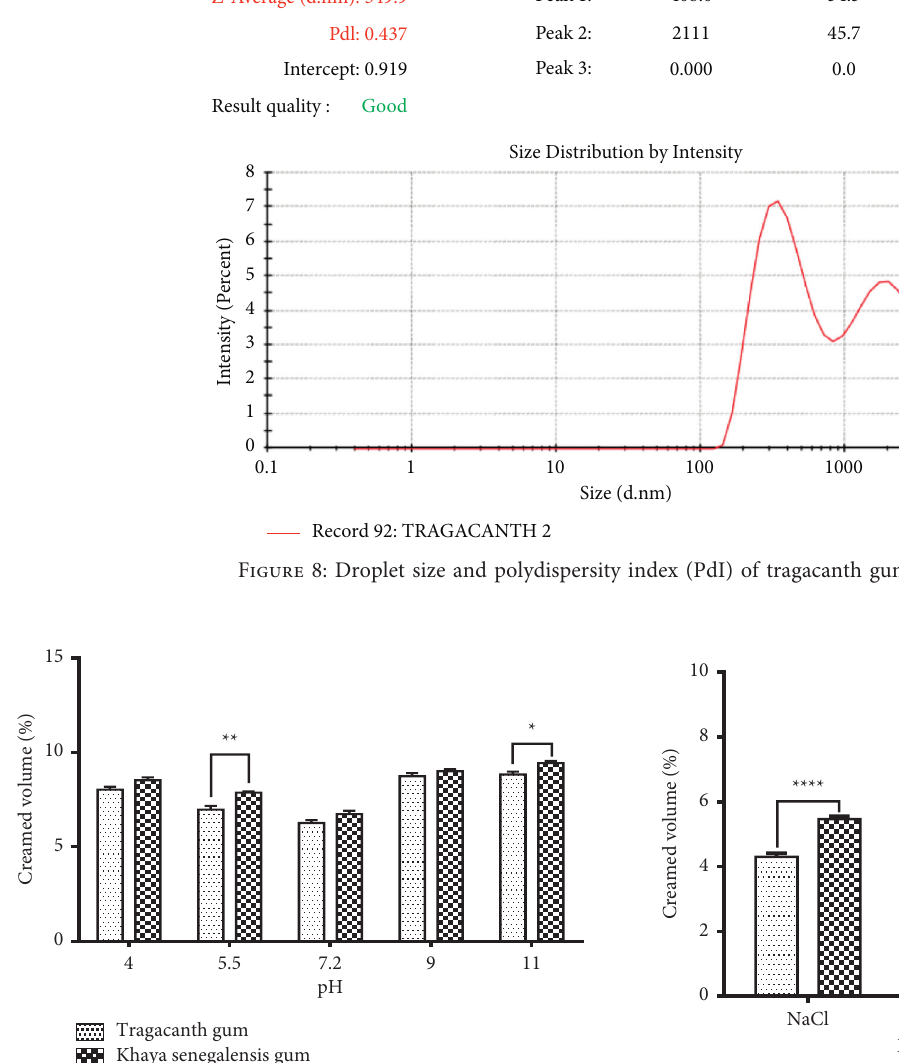
Figure 9: The effect of pH on castor oil emulsion using Khaya senegalensis gum as an emulsifier. Values are means ± SEM ( n � 3). ∗∗ P < 0 . 01 , ∗ P < 0 . 5 compared with emulsions with tragacanth gum (two-way ANOVA followed by Dunnett’s multiple compar- isons test).